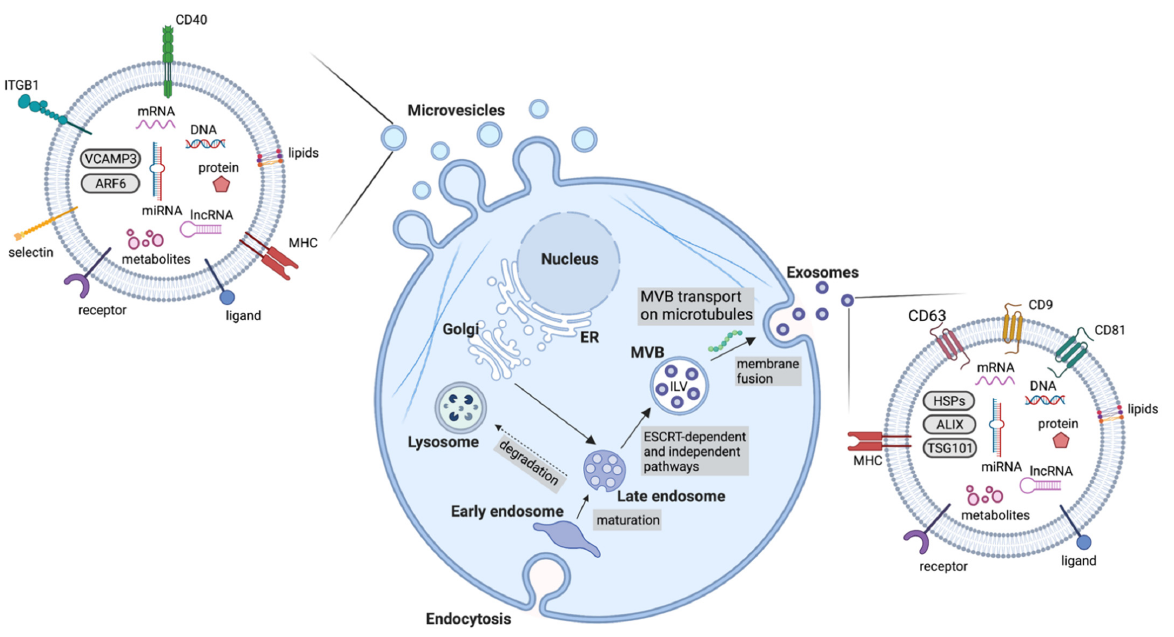
Figure 2. Schematic representation of exosome and microvesicle biogenesis, release and cargo. While microvesicles bud directly from the plasma membrane, exosomes are generated within MVB subpopulations that, upon maturation, fuse with the plasma membrane. Alternative MVB pathways include fusion with lysosomes for degradation. (Abbreviations: ALIX, ALG-2 interacting protein X; ARF6, ADP ribosylation factor 6; ER, endoplasmic reticulum; ESCRT, endosomal sorting complexes required for transport; HSPs, heat shock proteins; ILV, intraluminal vesicles; ITGB1, integrin β 1; lncRNA, long non-coding RNA; MHC, major histocompatibility complex; miRNA, microRNA; MVB, multivesicular body; TSG101, tumour susceptibility gene 101; VCAMP3, vesicle-associated membrane protein 3). Table 1. Classification and key features of extracellular vesicles.